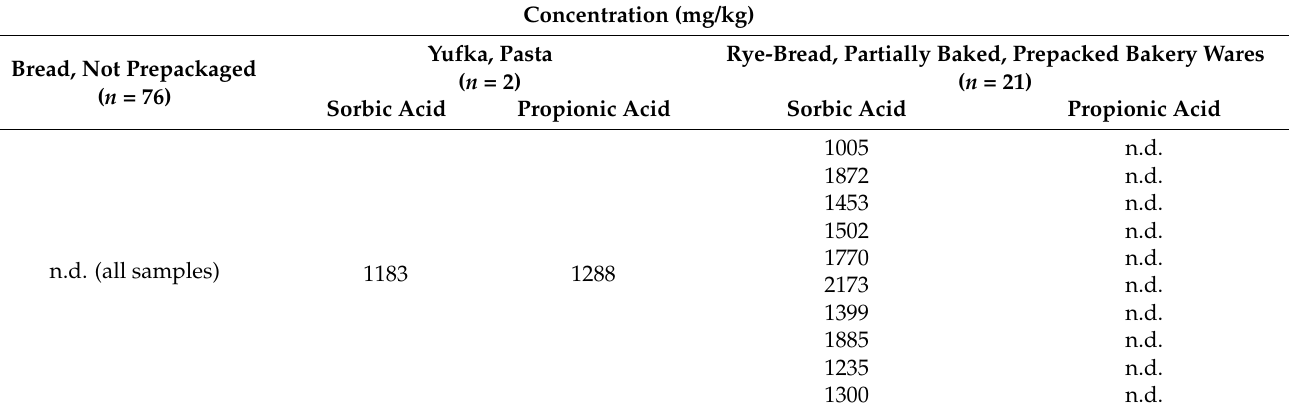
n.d. (all samples)